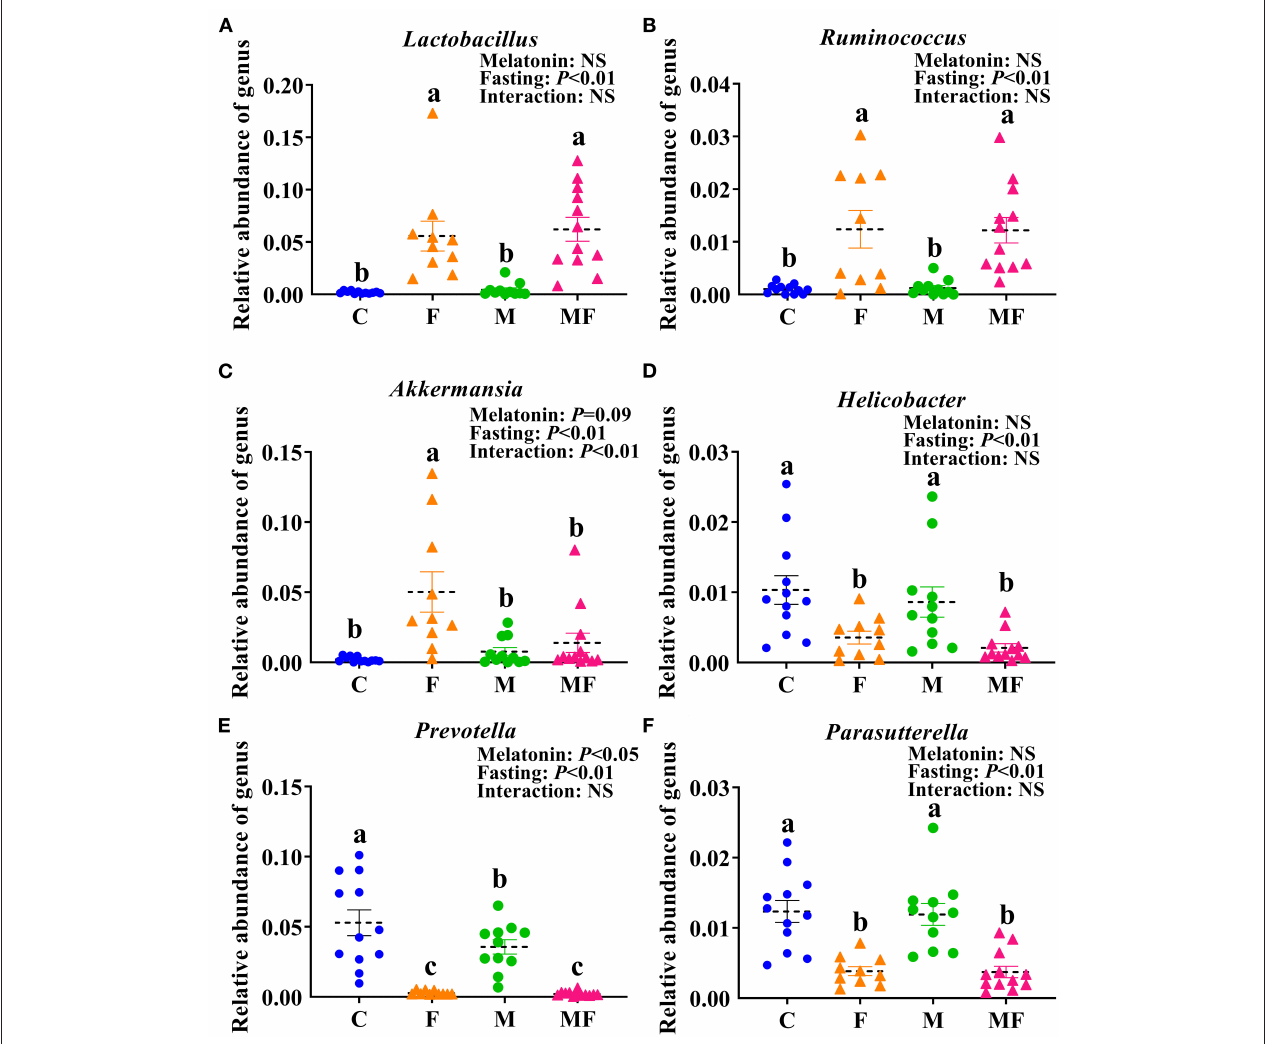
FIGURE 7 | The effects of intermittent fasting and melatonin supplementation on intestinal microbiota at the genus level in mice. Data are presented as mean ± SEM, n = 12; Labeled means without a common letter differ ( P < 0.05), NS: P ≥ 0.05. C, control; F, intermittent fasting; M, melatonin; MF, intermittent fasting plus melatonin. The C and M mice were fed ad libitum , while the F and MF groups underwent alternative-day feed deprivation. The M and MF groups mice were supplemented with melatonin at a dose of 10 mg/kg body weight by drinking. The relative abundance of Lactobacillus (A) , Ruminococcus (B) , Akkermansia (C) , Helicobacter (D) , Prevotella (E) , and Parasutterella (F) in